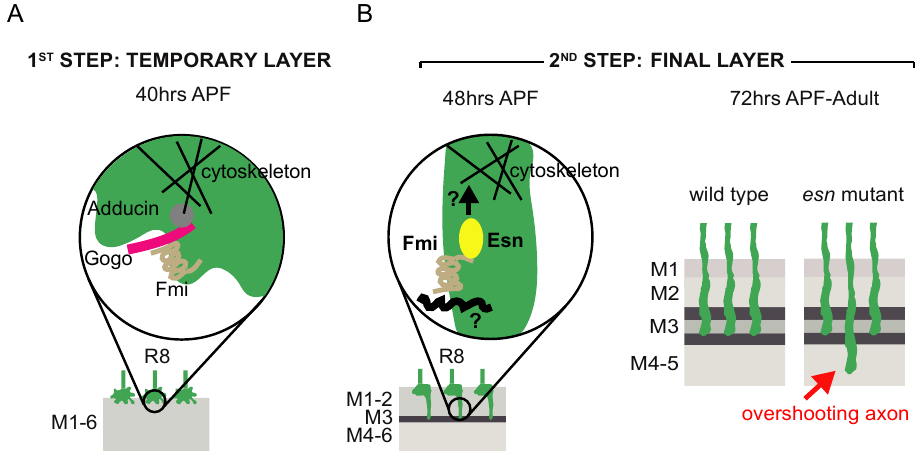
Figure 4. A model for R8 layer selection. ( A ) Molecular machinery present in the first step of R8 layer selection when growth cones reach their temporary layer. Gogo and Fmi interact in cis . The cytoplasmic domain of Gogo mediates signaling that modulates the cytoskeleton and Fmi function [17,18,32]. ( B ) Model proposed for the second step of R8 layer selection when R8 growth cones extend to their final target layer and transform into synaptic terminals. We propose that Fmi could signal through Esn to modulate the cytoskeleton and mediate stabilization in the final target layer. Most probably other cell surface molecules, acting in cis with Fmi and / or in parallel, are involved in this process.